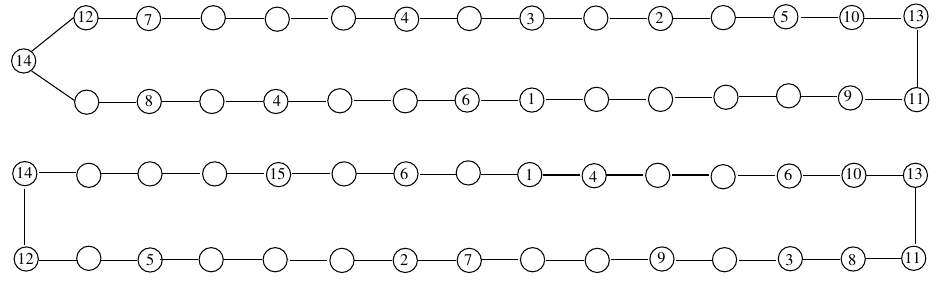
Figure 10: Antiregular dominating labelings of C